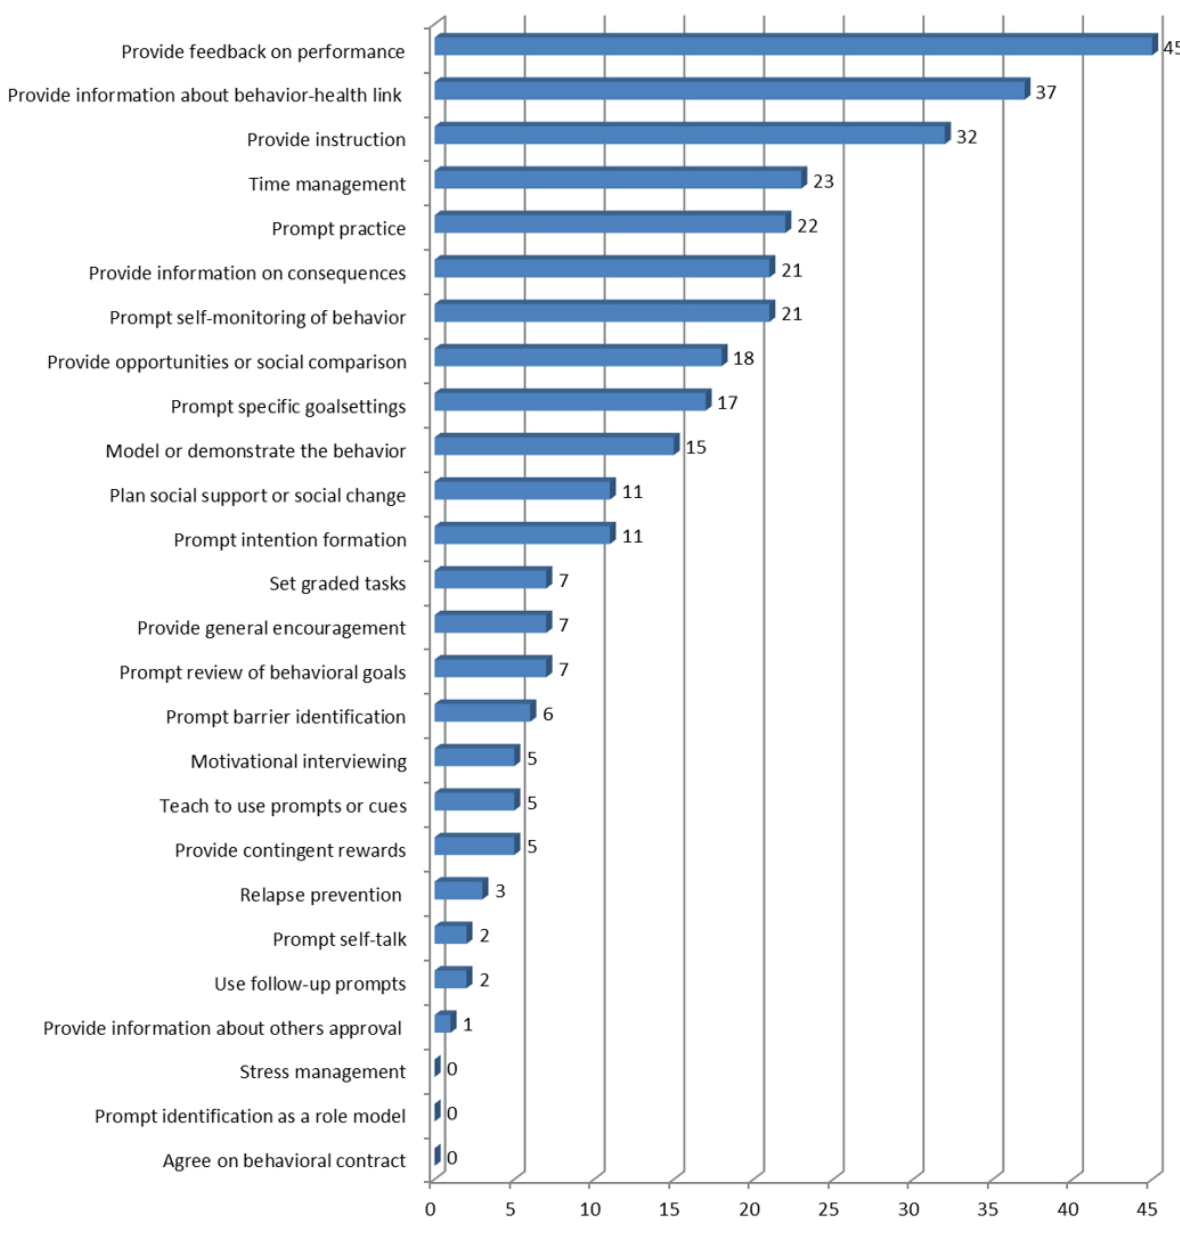
Figure 2. Frequencies of the behavior change techniques found in apps using the taxonomy by Abraham and Michie